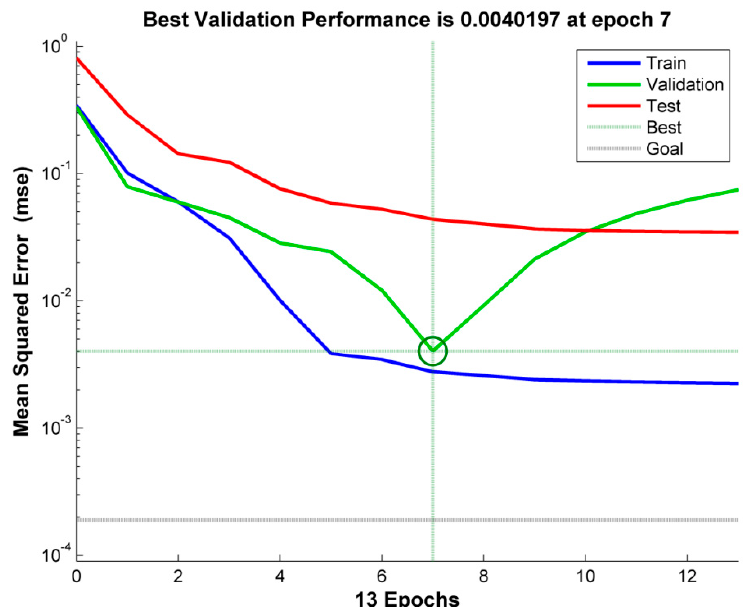
Figure 4. The lowest mean squared error for validation in 4-3-3-1 neural network architecture for the prediction of fractal dimension in WEDM.